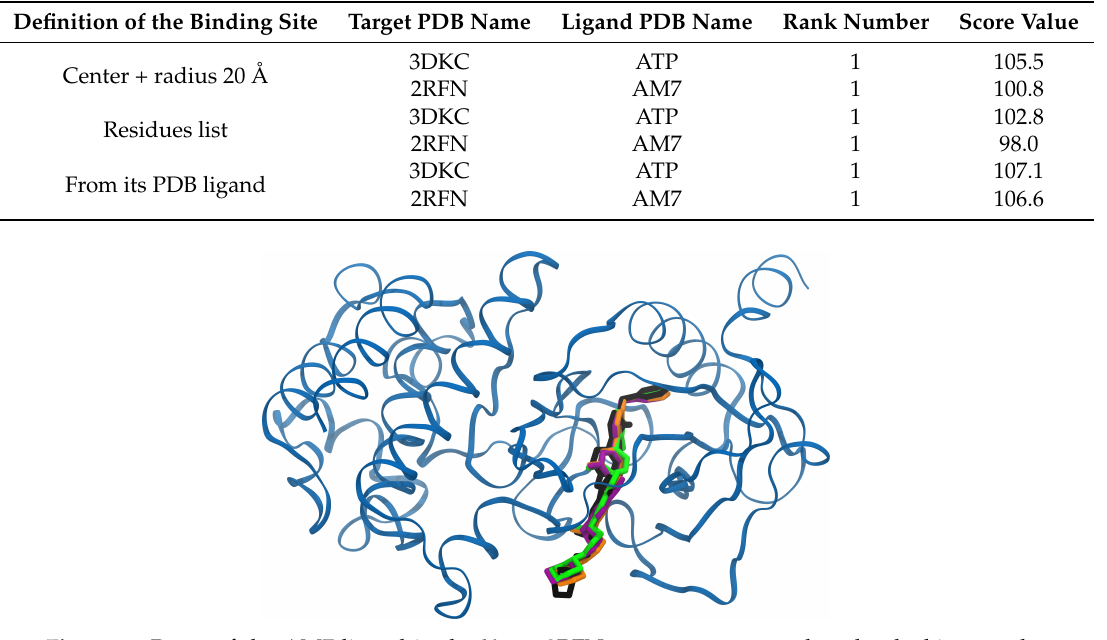
Figure 3. Poses of the AM7 ligand in the X-ray 2RFN structure compared to the docking results. In black, the original pose of the ligand in its PDB protein conformation; in colors, the best docking poses obtained by GOLD on the 2RFN target using a definition of the binding site from a list of residues (orange), from the original ligand (green), and from a center-point